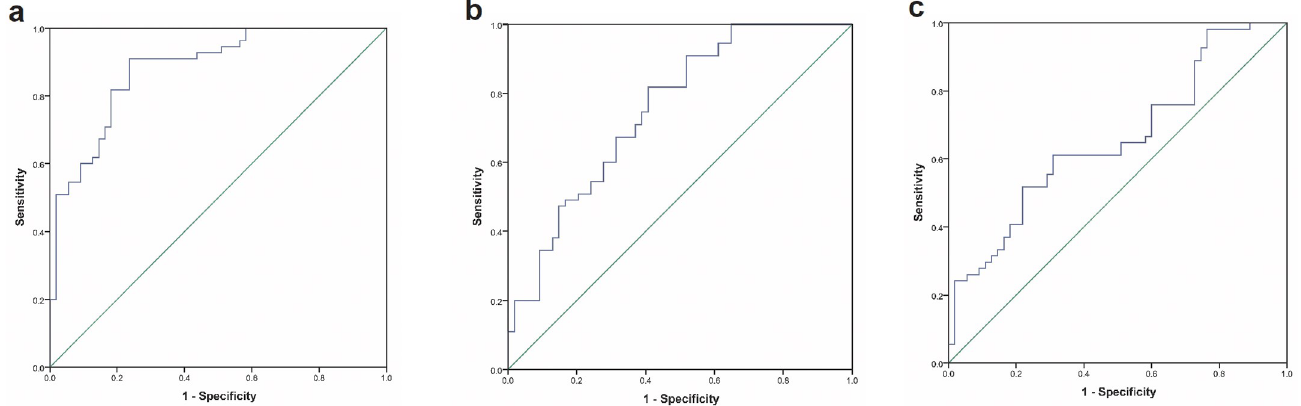
Fig 3. ROC curve for discrimination between a) T2DM-NP and control, b) T2DM and control and c) T2DM and T2DM-NP.